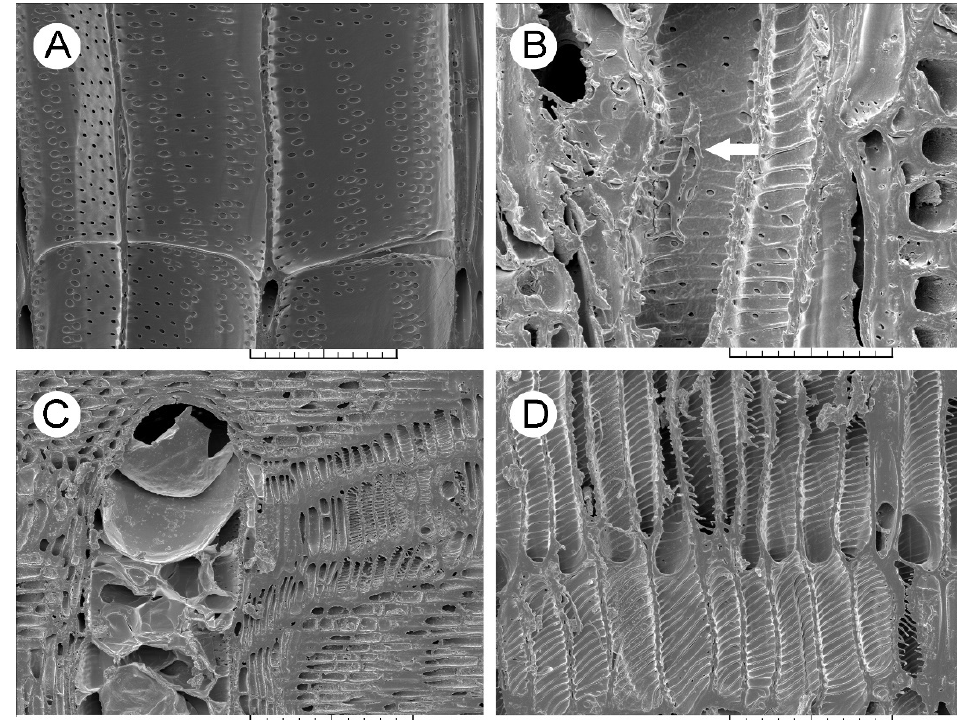
Figure 2. Scanning electron microscopy images of earlywood vessels in the sixth annual growth ring of ‘Dodoens’ trees. ( A ) The non-infected tree, radial section, scale bar = 100 µm. ( B ) The hyphae (white arrow) spread on the radial wall surface of an earlywood vessel, radial section, scale bar = 50 µm. ( C ) An earlywood vessel occlusion through tyloses following the fungal infection, radial section, scale bar = 200 µm. ( D ) Rapid formation of a large number of narrow earlywood vessels as the immediate response to the fungal infection, radial section, scale bar = 100 µm.